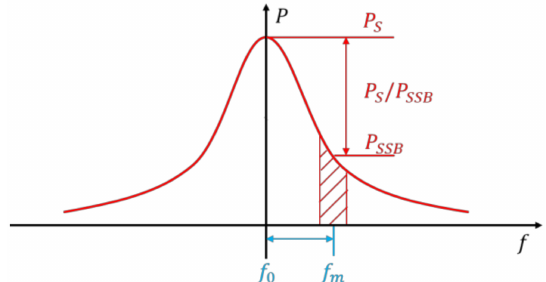
Figure 12. Definition of phase noise.